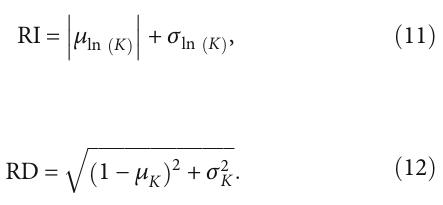
Figure 5: Measured versus predicted B paper,